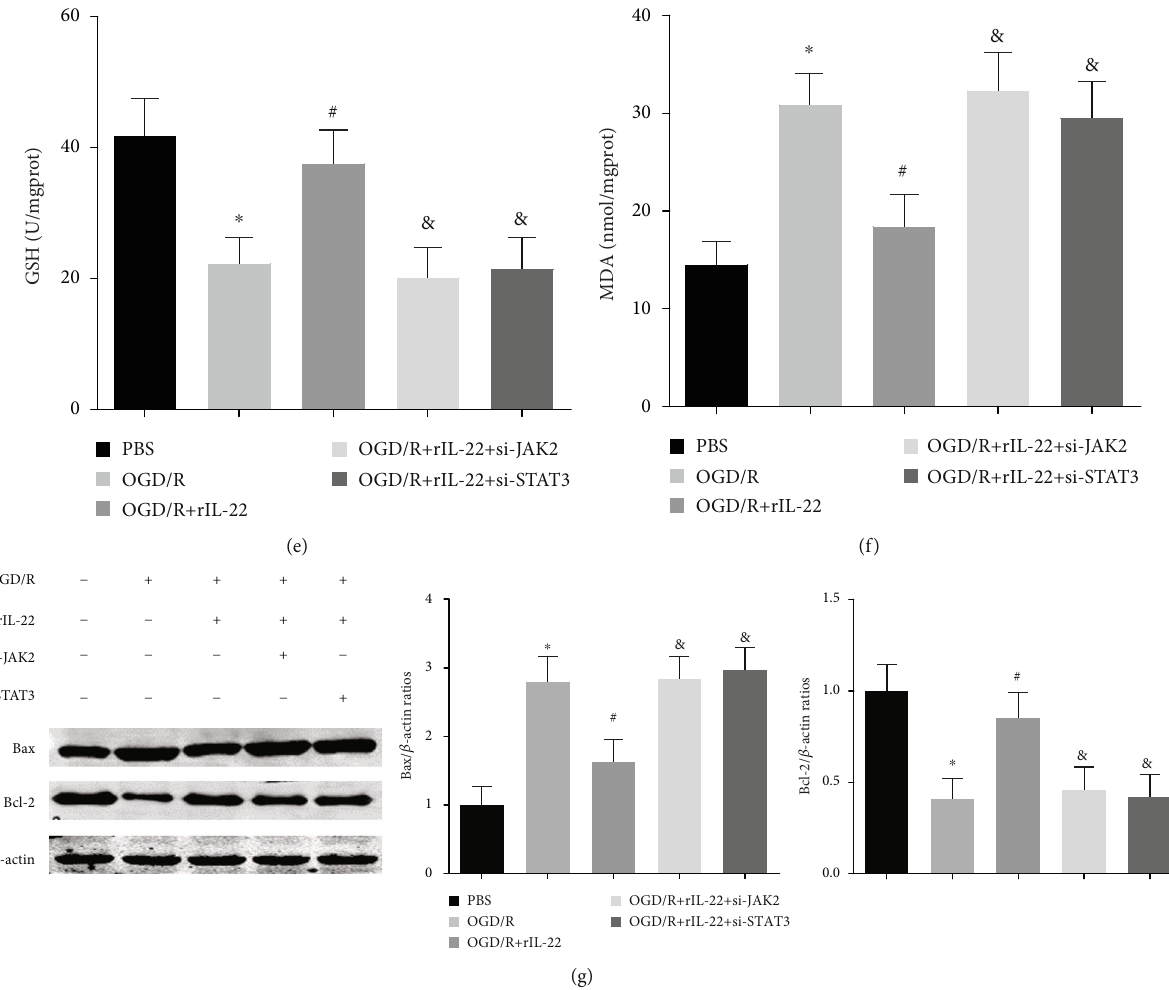
Figure 7: JAK2 and STAT3 knockdown abolished IL-22-mediated neuroprotection. The mRNA expression of IL-1 β (a), MCP-1 (b), and TNF- α (c) was detected in PC12 cells ( n = 6 ). The levels of SOD (d), GSH (e), and MDA (f) were detected in PC12 cells ( n = 6 ). (g) The expression of Bax, Bcl-2, and β -actin was detected by western blotting ( n = 4 ). ∗ P < 0 : 05 vs. PBS group; # P < 0 : 05 vs. OGD/R group; & P < 0 : 05 vs. OGD/R+rIL-22